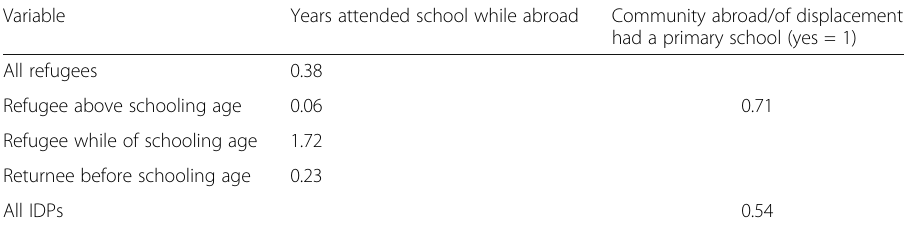
Table 6 Experiences while in